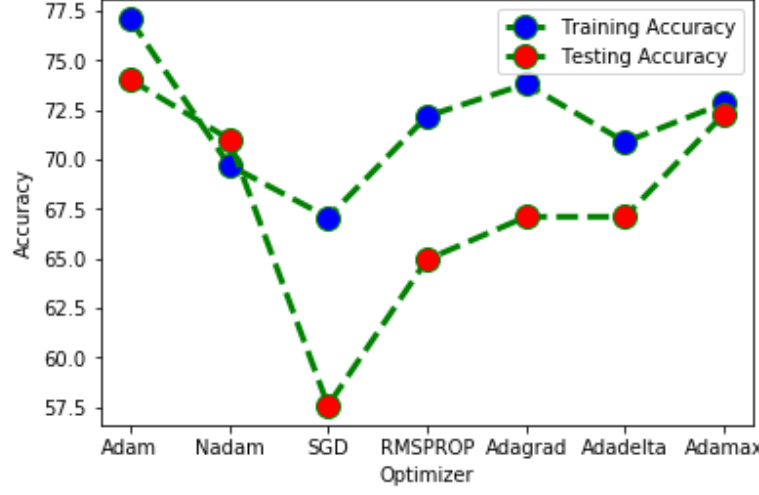
Figure 3. Performance Evaluation of